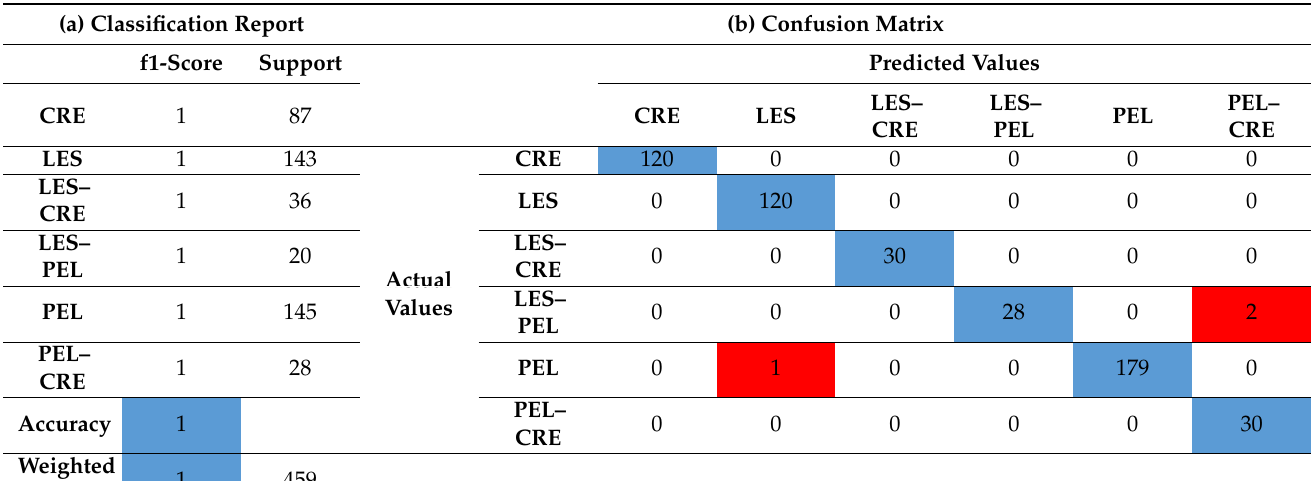
Table 1. ( a ) Classification report and ( b ) confusion matrix for LDA external validation.